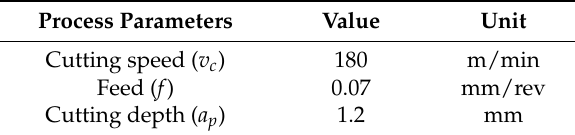
Table 1. Process parameters for cutting tests.